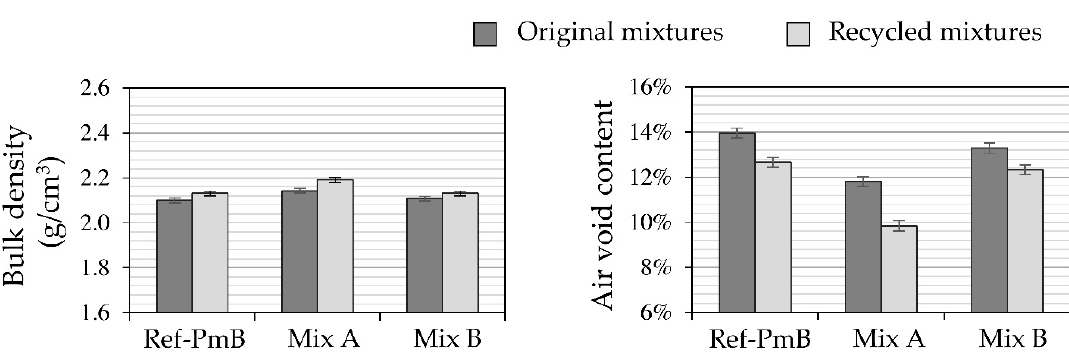
Figure 4. Volumetric properties of the asphalt mixtures.